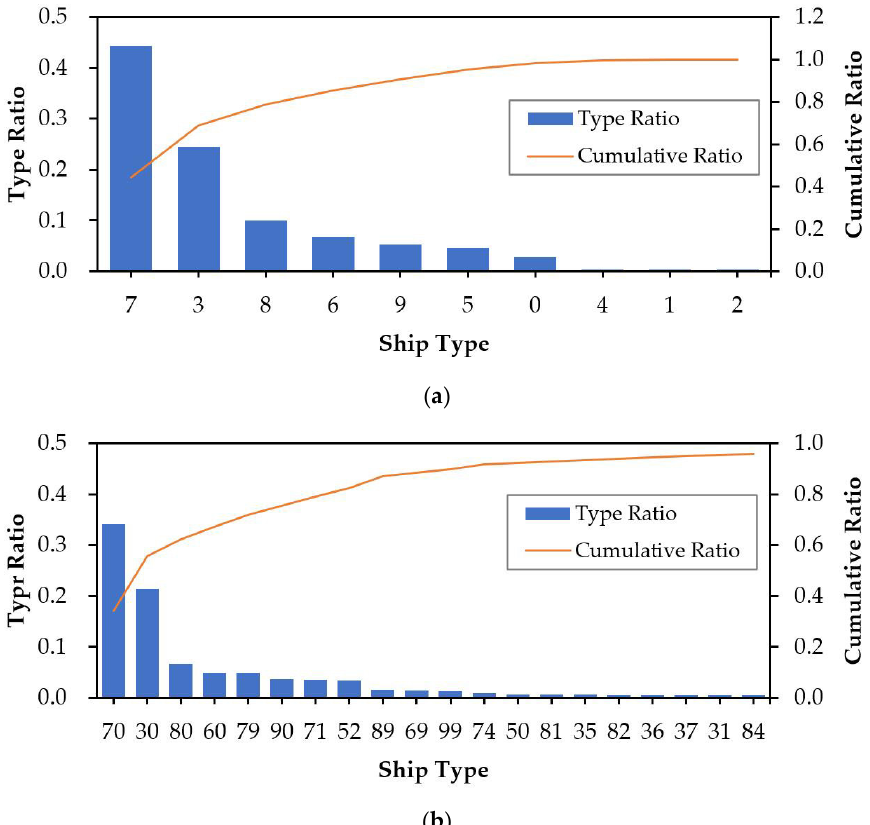
Figure 2. The distribution of ship types in the AIS data. ( a ) The distribution of ship types by ship category codes; ( b ) the distribution of the top 20 ship types with the largest number by ship subcategory code. Table 2. The corresponding relationships between AIS ship type codes and ship